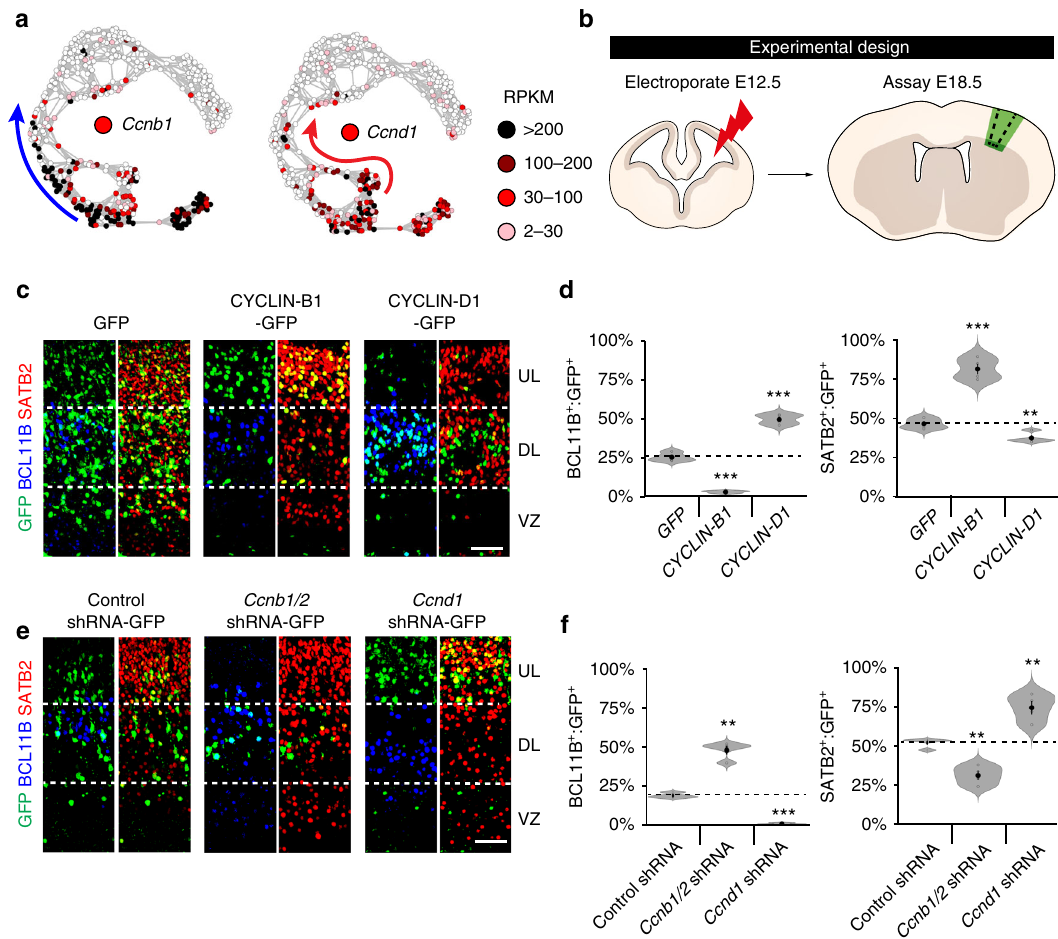
Fig. 6 Cell-cycle phase-speci fi c CYCLIN ’ s affect cortical cell-fate decisions. a t SNE-NN maps coloured by the expression levels of Ccnb1 or Ccnd1 . b Schematic of cortical electroporations performed at E12.5 and processed for immunohistochemistry at E18.5. c – f Immunohistochemistry and quanti fi cation of BCL11B (blue) or SATB2 (red) expression in cortical cells electroporated with vectors expressing GFP (green) either alone or together with CYCLIN-B1 ( P -values (vs. GFP); BCL11B 2.33e-4, SATB2 5.5e-4) or CYCLIN-D1 ( P -values vs. GFP; BCL11B 3.25e-5, SATB2 8.48e-3) ( c , d ), control shRNA,